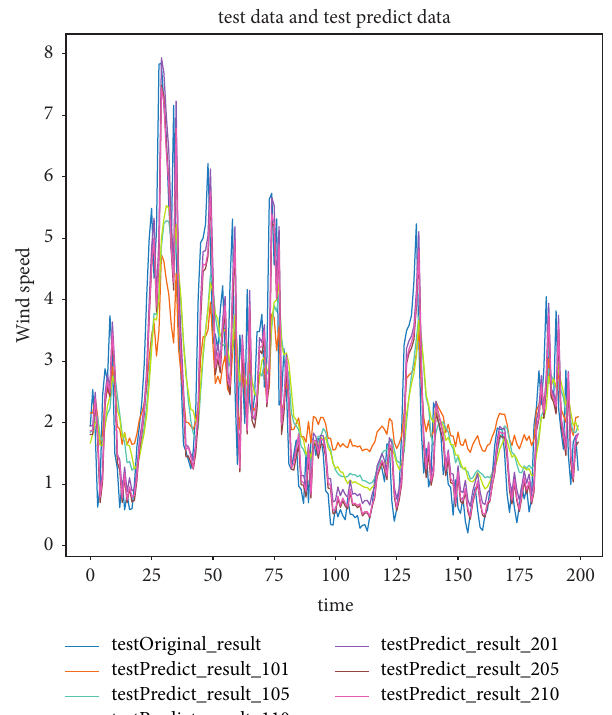
Figure 8: Test results of partial